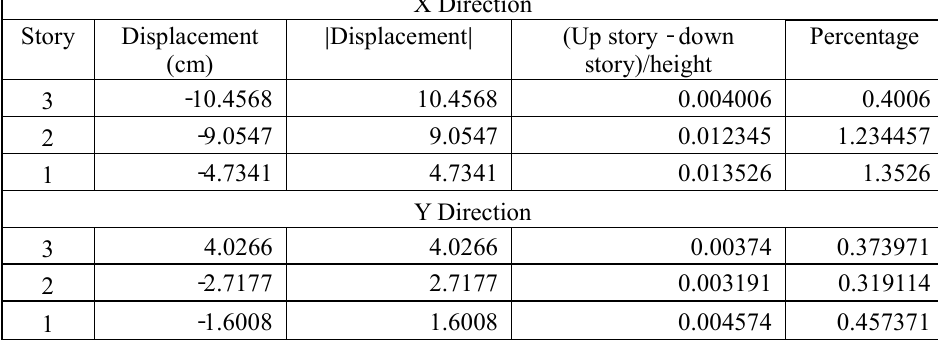
The results of 3-story structure under Northridge earthquake record in U1